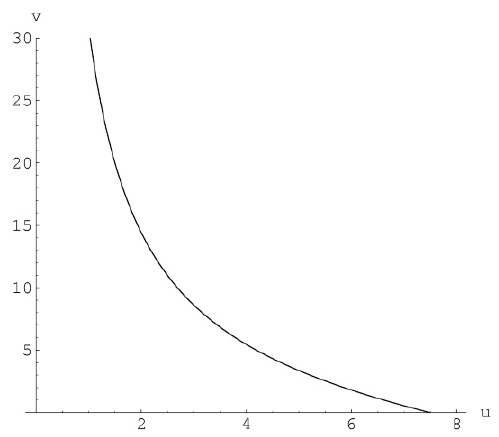
Figure 1. The domain u 2 + u (2 v + ‘ ) ≤ t/ (2 π ) for t = 400 , ‘ = 1